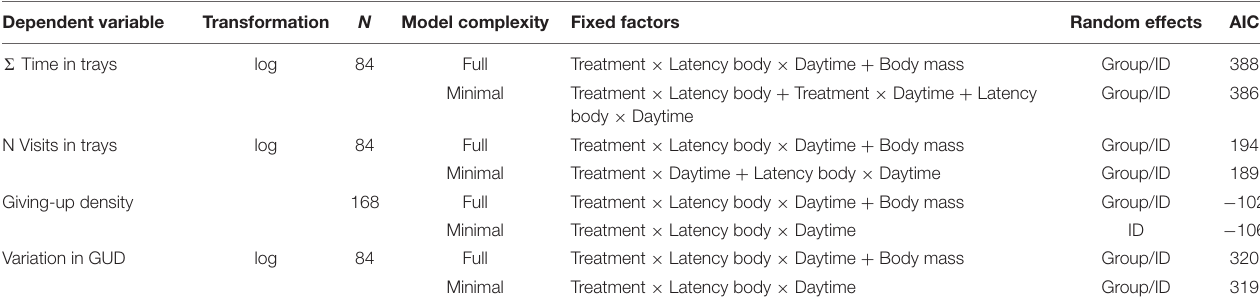
TABLE 1 | Full and minimal linear mixed models testing the effects of independent variables and their interactions on response variables measured during the arena experiment in bank voles (N Individuals = 21). Dependent